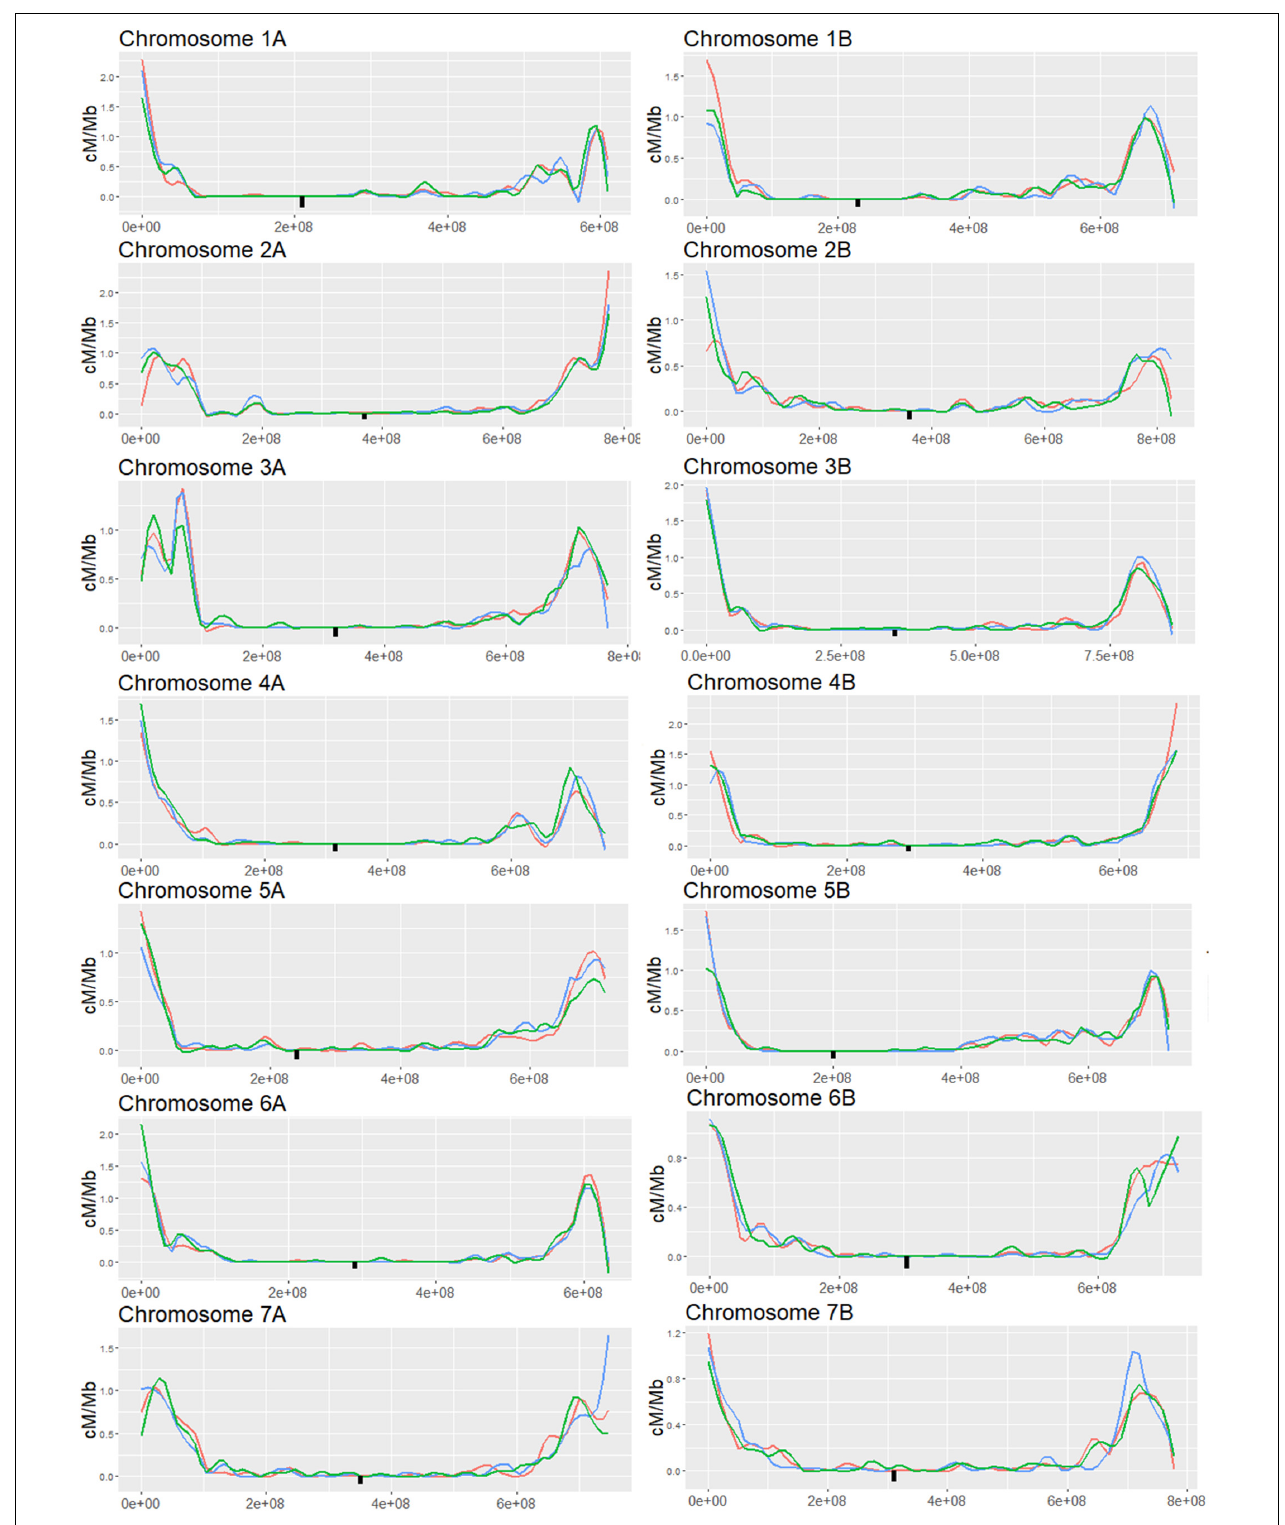
FIGURE 4 | Genome wide analysis of F2 (Zavitan x Svevo) populations derived from F1 plants which were treated by either MET1-VIGS or XRCC2-VIGS during meiosis or untreated (WT). COs were analyzed in F2 progenies by GBS method followed by NGS Illumina sequencing. Chromosomes were divided into 1 Mb bins which were genotyped according to the ratio of mapped reads. Genetic distance in centi-Morgans per mega base pairs ( Y axis) is shown along each chromosome ( X -axis represent bp in Zavitan chromosomes). Blue, WT control; Red, MET1-VIGS treatment; Green, XRCC2-VIGS treatment; Black square, centromere position.